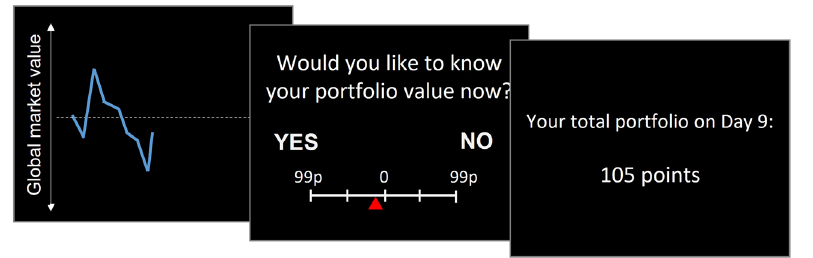
Figure 2. Stock market task. Participants observed the market going up or down on each trial. They were then asked whether they want to find out the value of their portfolio and had 8 s to indicate this using a willingness to pay scale. Specifically, the more they paid towards ‘YES’ the more likely they would be to receive information, and the more they paid towards ‘NO’ the more likely they would remain ignorant. They then received feedback for 3 s with either the value of their portfolio or ‘XX